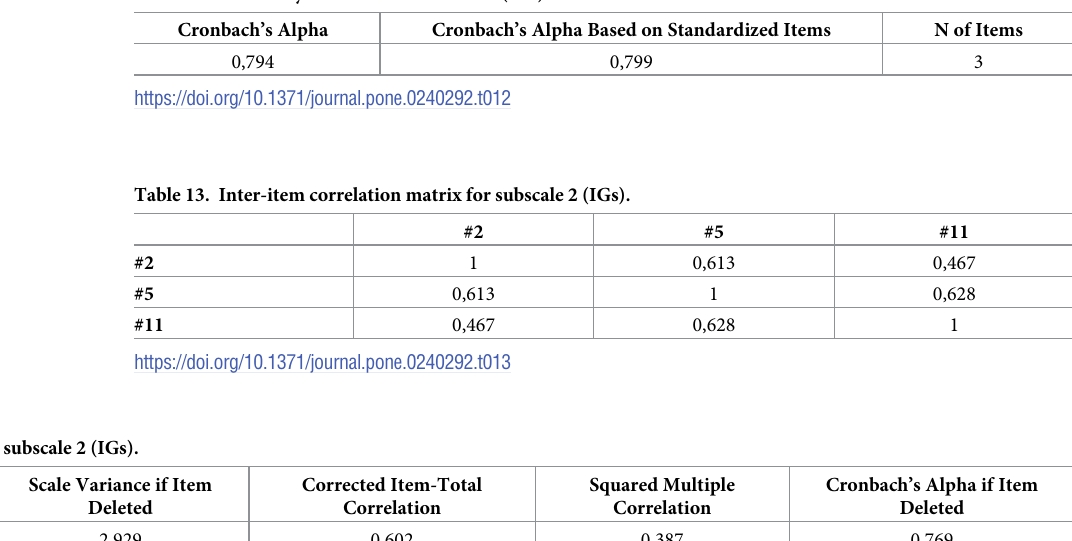
Table 12. Reliability statistics for subscale 2 (IGs).